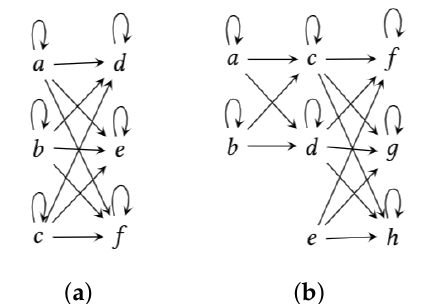
Figure 4. ( a ) Combinatorial architecture of a fully connected layer, one layer formed by a , b , c and the other by d , e , f . This architecture has no restrictions on the weight nor the activation architectures. ( b ) Two consecutive fully connected layers, first layer connecting a , b with c , d , and the second connecting c , d with f , g , h and e is a bias vertex. The first without bias and the second with bias. Note that there is no loop (activation function) on the bias vertex e